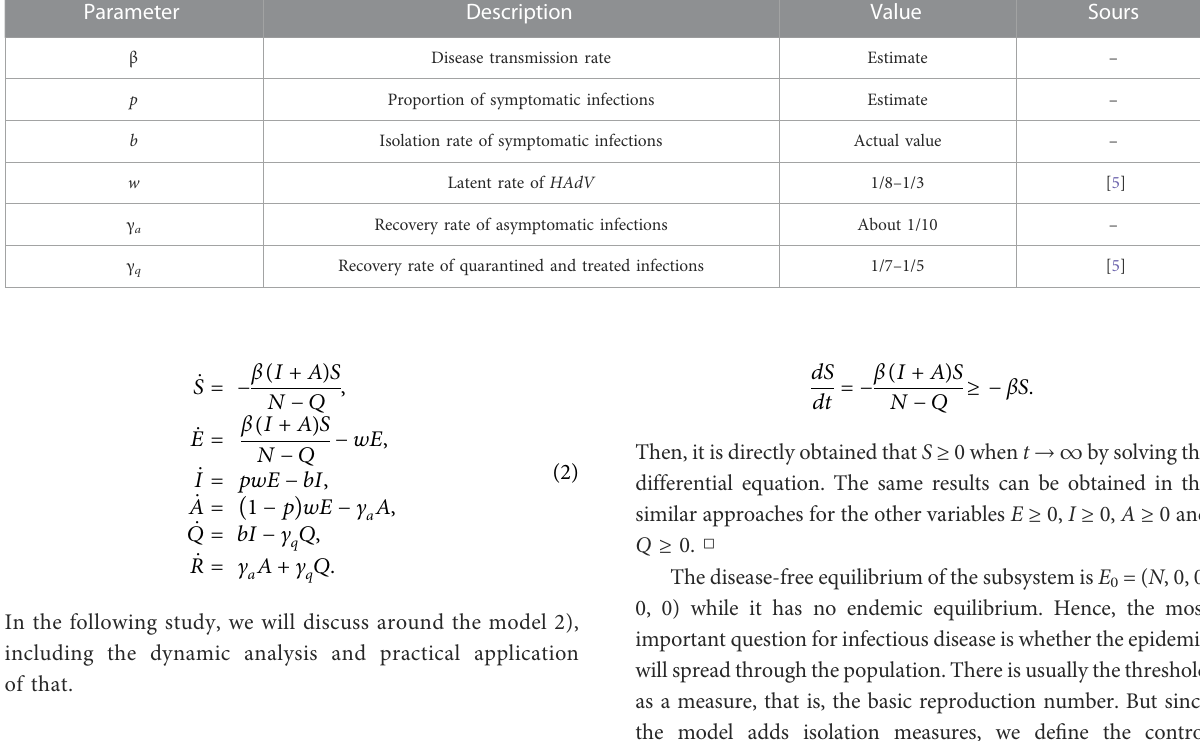
TABLE 1 Parameter description and value for model 2.